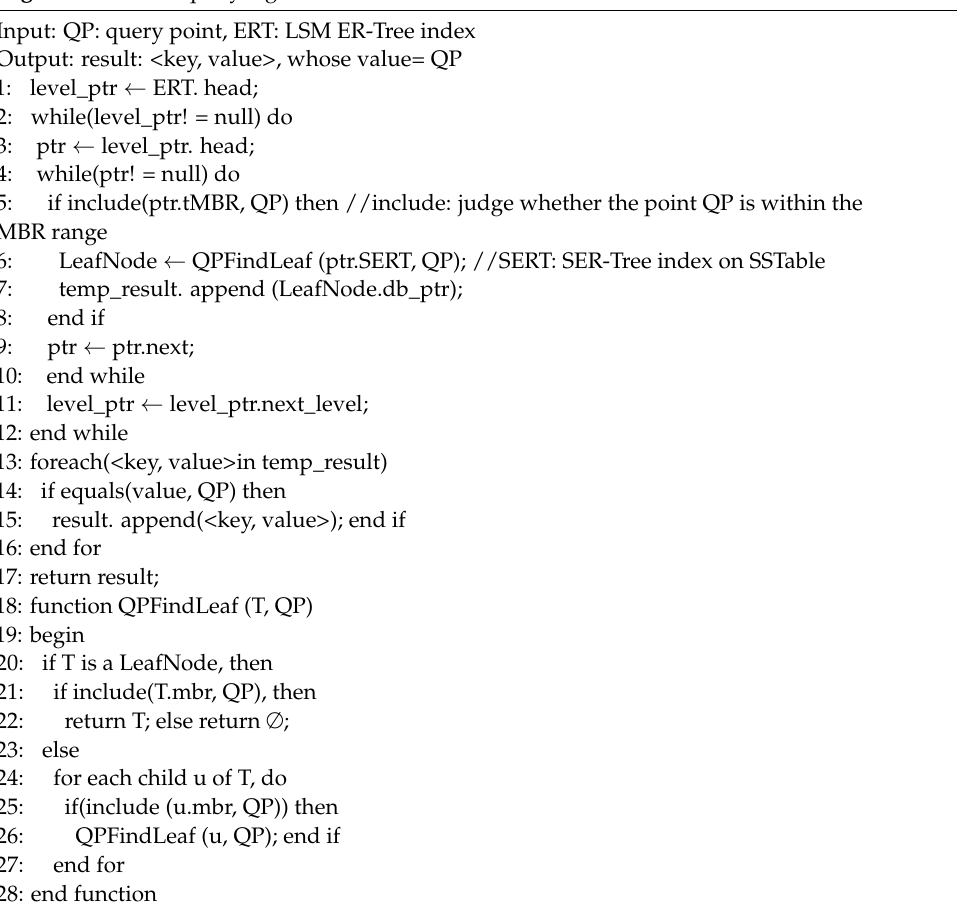
Algorithm 2 Point query